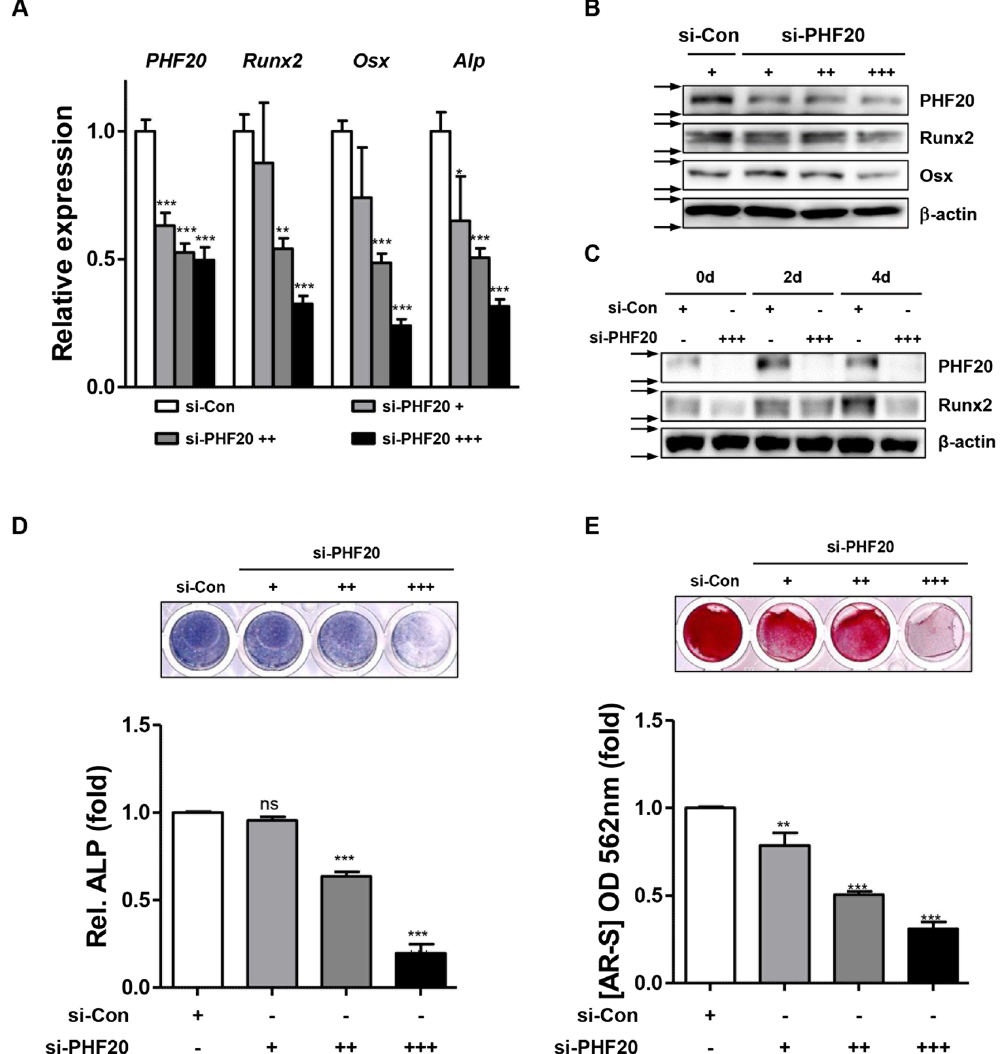
Figure 3. Knockdown of PHF20 reduces osteoblast differentiation. Cells were transfected with si-Control and si-PHF20 ( + , 30 nM; ++ , 60 nM; +++ , 90 nM) for 2 days. mRNA and proteins were extracted for qRT-PCR ( A ) and Western blot analyses ( B ). For time course effects, cells were treated with si-PHF20 (90 nM) for 4 days, and Western blot analysis was performed ( C ). Arrows ( → ) indicate cropping lines and blots were obtained under the same experimental conditions ( B , C ). Cells were stained for ALP at day 3 ( D ), AR-S was performed at day 8 of culture ( E ). For quantitation, ALP stained cells were quantified using ImageJ software ( D , lower). Alizarin red stained cells were extracted with 10% cetylpyridinium chloride and the absorbance value was measured at 562 nm by spectrophotometry ( E , lower). Values are expressed as means ± SEM (n = 3). ** p < 0.01 and *** p < 0.001 compared to